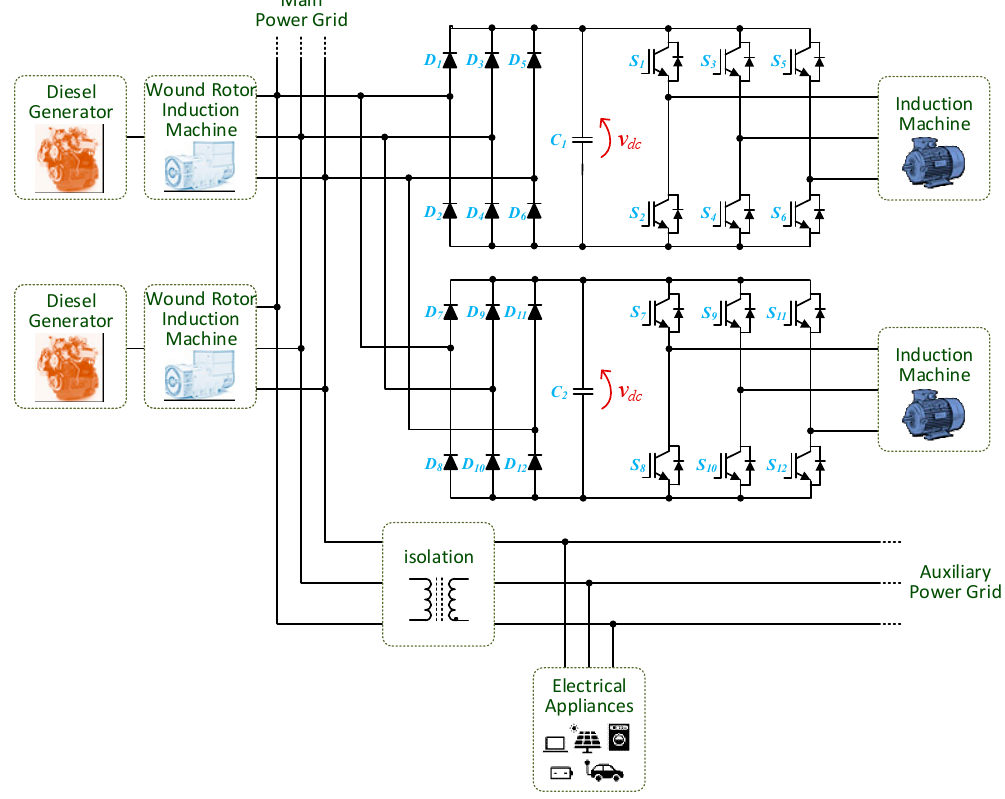
Figure 34. Typical structure of an electric ship power system based on two induction machines.